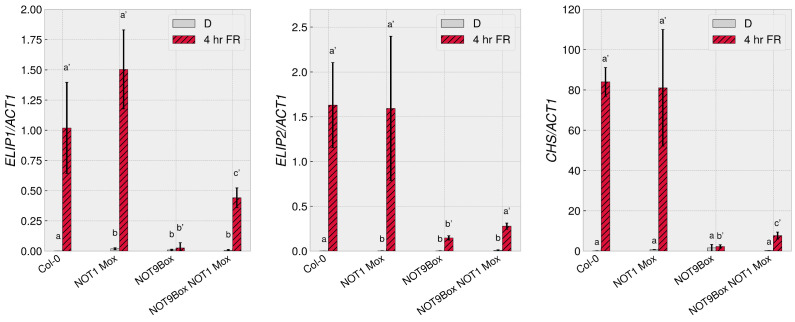
NOT1 M overexpression partially rescues NOT9Box gene expression defects.Quantification of ELIP1, ELIP2, and CHS transcript levels in wildtype seedlings, seedlings expressing p35S:FLAG-myc-mCherry-NLS-NOT1 M (NOT1 Mox) or p35S:HA-YFP-NOT9B (NOT9Box, line 21c), and NOT9Box NOT1 Mox double transgenic seedlings. Four-day-old dark-grown seedlings were exposed to FR light for 4 hr or kept in the dark. Total RNA was extracted and ELIP1, ELIP2, CHS, and ACT1 transcript levels were quantified by qRT-PCR. Bars represent biological triplicates (± SD). Letters indicate levels of significance as determined by one-way ANOVA followed by post-hoc Tukeys HSD test; p<0.05.